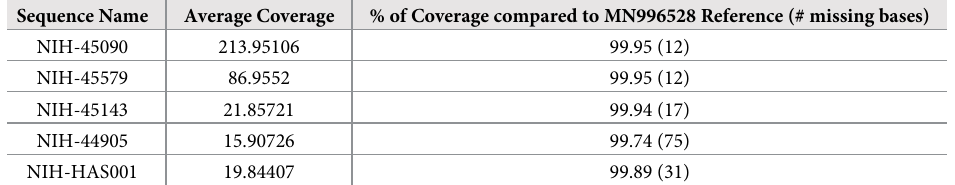
html). The Nextstrain classification has grouped SARS-CoV-2 strains into five major global clades: 19A, 19B, 20A, 20B and 20C. Phylogenetic analysis based on the whole genomes showed that three strains NIH-45090, NIH-45143, and NIH-45579 belong to 20A clade and clustered with strains from Oman, Slovakia, United States and Pakistani strain EPI_ISL_513925. The other two strains (NIH-44905 and NIH-HAS001) grouped into 19B clade along with viruses from India and Oman (Fig 2). Based on analysis of available sequence data from Pakistan, we have observed 8 separate introductions of SARS-CoV-2 into Pakistan (the earliest sequence is from March 12, 2020). Most of these clades consist of a single sequence, except for the two clades presented here, and a third monophyletic clade from Lahore collected on November 5, 2020. Our analysis suggests multiple importations of SARS-- CoV-2 into Pakistan and provides evidence of clustered outbreak/community transmission. We have analyzed the genome-wide single-nucleotide polymorphisms (SNPs) and found nine common nucleotide variations (241C > T, 2416C > T, 3037C > T, 8371G > T, 11083G > T, 14408C > T, 22477C > T, 23403A > G, and 25563G > T) among Pakistani viruses of clade GH compared with the reference Wuhan strain (NC_045512). In addition, strain NIH-45090 showed 28027G > T & 29696C > T, NIH-45143 displayed 10738T > A, 25706T > C & 29868G > A and NIH-45579 had 1613C > T, 3613T > C, 18603T > C, 18788C > T, 28378G > C & 28878G > A nucleotide changes. The Pakistani S clade strains contained nine common SNPs (2461T > C, 8782C > T, 11230G > T, 24051A > C, 26313C > T, 28144T > C, 28167G > A, 28878G > A, and 29742G > A). The strain NIH-44905 also had a nucleotide change at position 355C > T (Table 3). When compared with SARS-CoV-2 isolates submitted in GISAID from Pakistan at the same nucleotide positions, three strains UN-UVAS-Sialkot/2020 (EPI_ISL_548946), UN-UVAS-Lahore-I/2020 (EPI_ISL_548942) and KPK-KUST-SJTU/2020 (EPI_ISL_513925) showed same nucleotide variations at position 241C > T, 3037C > T, 14408C > T (ORF1ab) and 23403A > G (S-gene) compared to current study strains of GH clade (NIH-45090, NIH-45143, & NIH-45579). The KPK-KUST-SJTU/2020 contained nucleotide changes in ORF1ab (2416C > T, 8371G > T, 11083G > T), S-gene (22477C > T) and ORF3a (25563G > T). Further- more, Gilgit1/2020 (EPI_ISL_417444) strain had similar variations at 241C > T and 11083G > T in ORF1ab while KP-RMI-01/2020 (EPI_ISL_632908) showed a single change (11083G > T in ORF1ab) (Fig 3A). Table 2. Sequencing stats of the five Pakistan